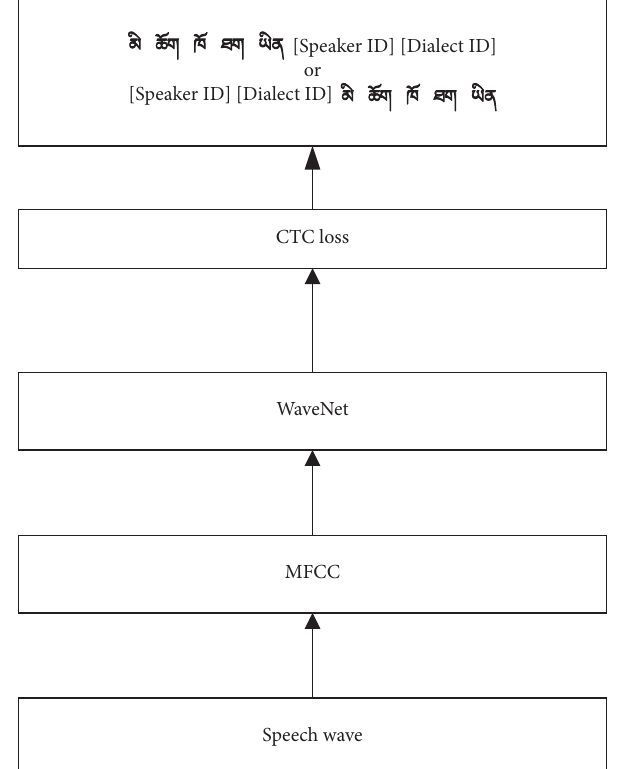
Figure 1: The baseline